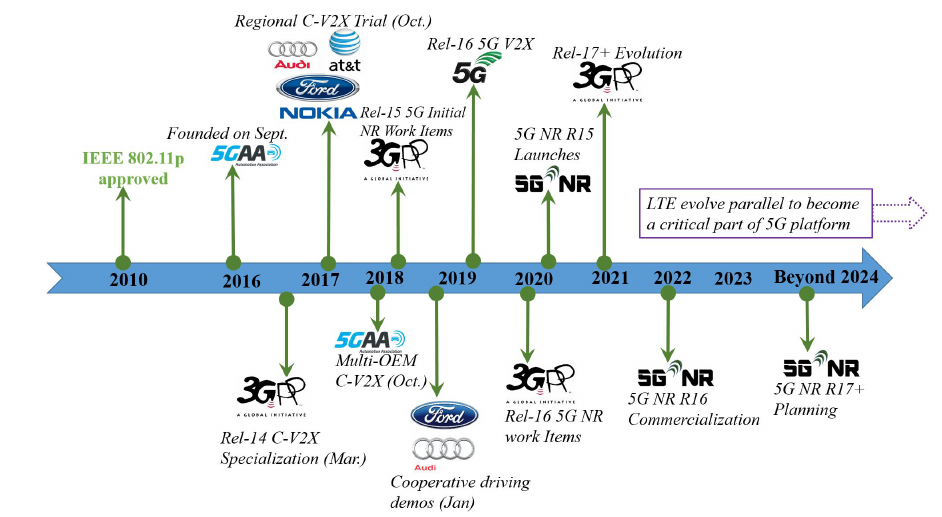
Figure 5. Evolution of C-V2X towards 5G NR V2X